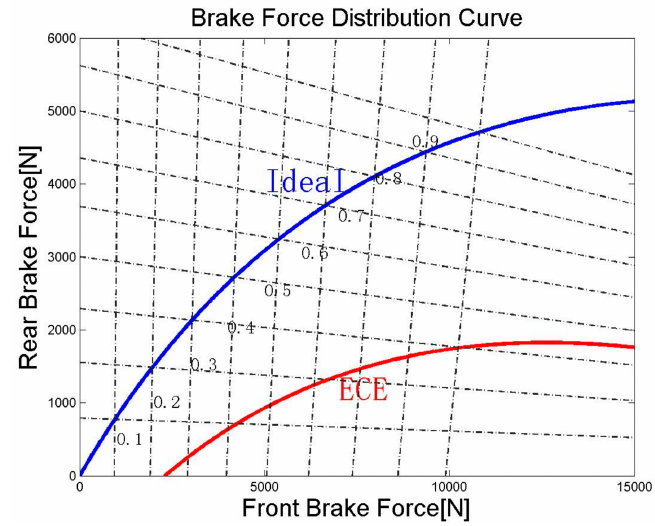
Figure 8. Braking force distribution on the front and rear